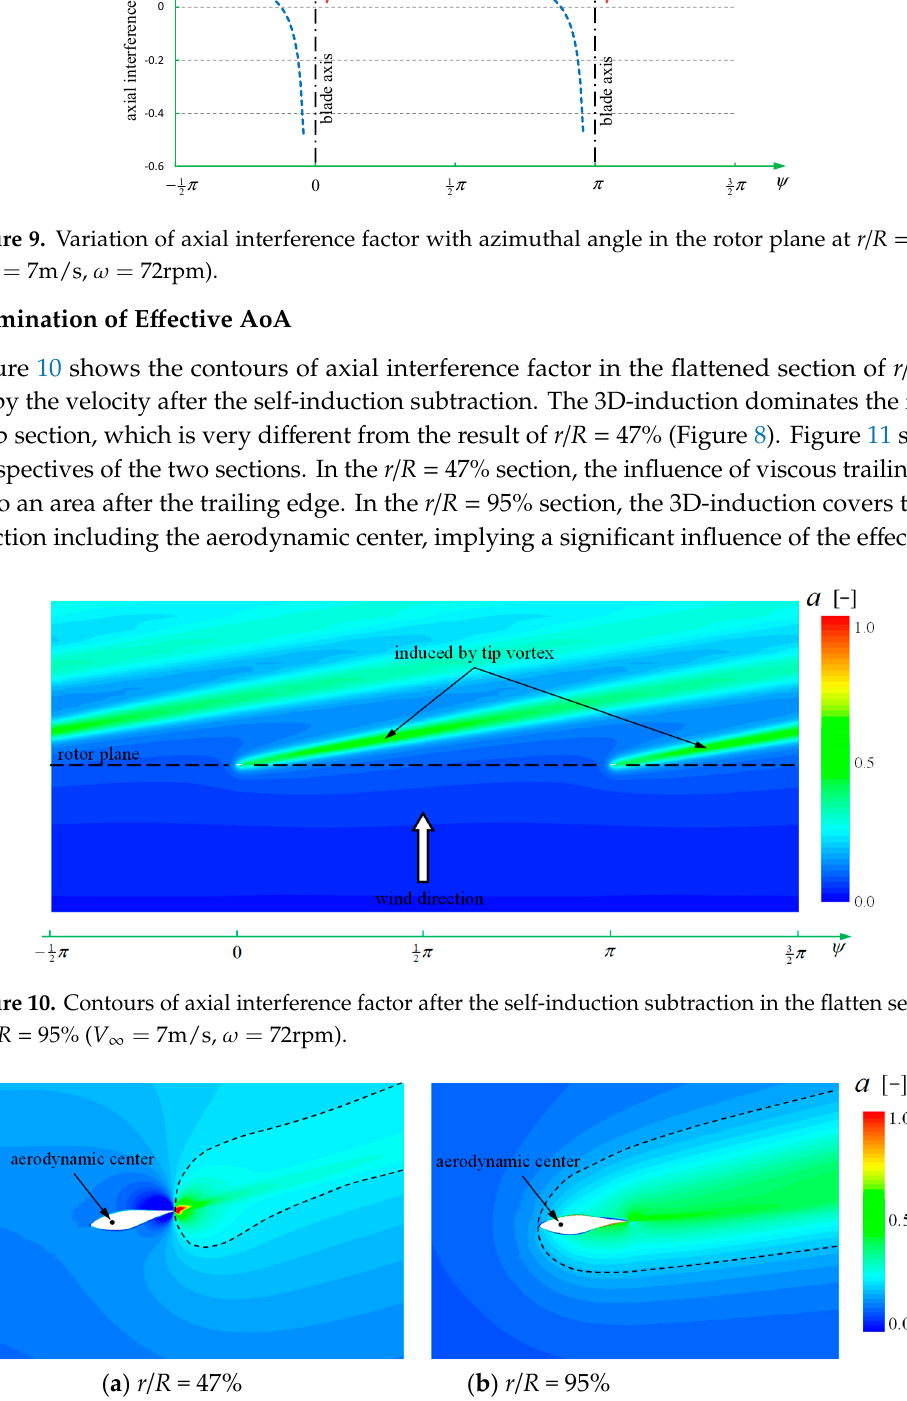
Figure 11. Contours of axial interference factor after the self-induction subtraction around the blade